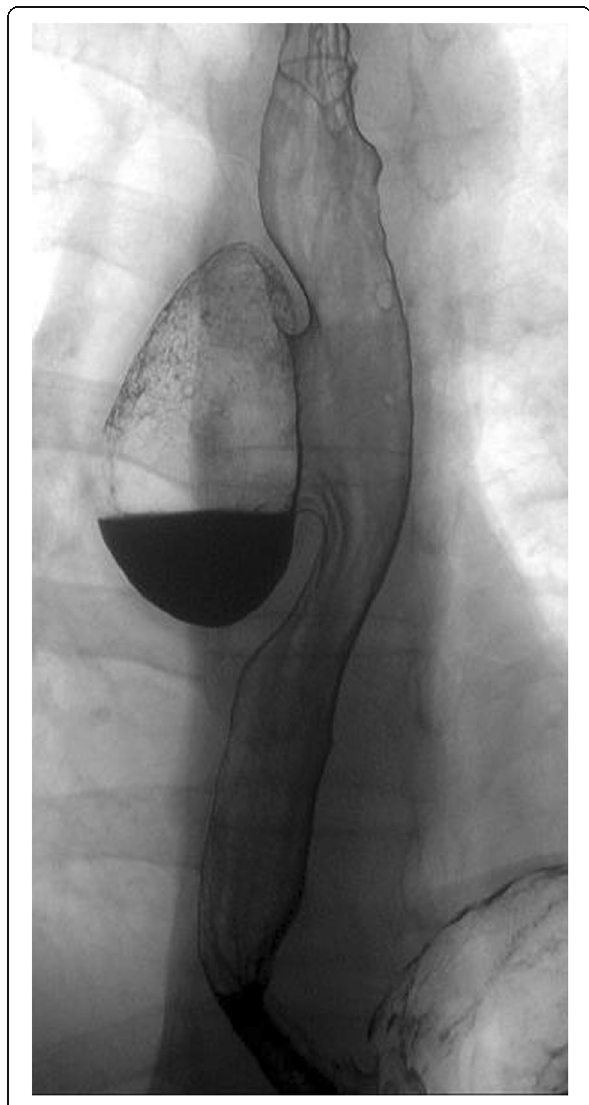
Fig. 1 Barium esophagogram of a large diverticulum in the middle esophagus before